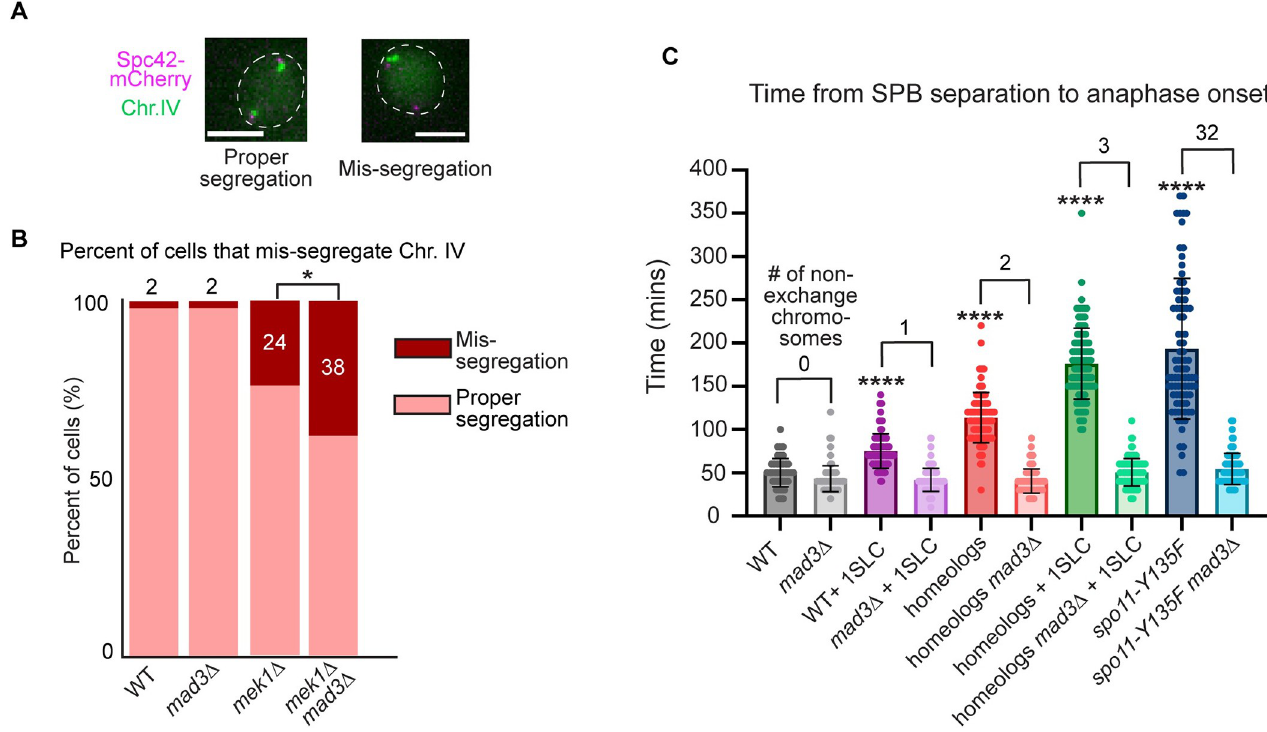
Fig 2. Three nonexchange chromosomes signal a similar average duration of the spindle checkpoint delay as 32 non-exchange chromosomes. A) Representative images of a cell in which both homologs of chromosome IV are tagged with a GFP focus at anaphase I. Scale bar = 5 μ m. B) Graph of percent mis-segregation of chromosome IV during meiosis I. Asterisk indicates a statistically significant difference from wildtype (Fisher’s Exact test; p = 0.0327). n � 100 cells per genotype. C) Graph of mean time from SPB separation to separase biosensor activation. Numbers above bars indicate the number of non- exchange chromosomes in each genotype. Asterisk represents statistically significant difference between wildtype and the indicated genotype (p < 0.0001, Mann-Whitney test), and error bars show SD. n � 100 cells per genotype. KT = kinetochore. SLC = short linear chromosome.